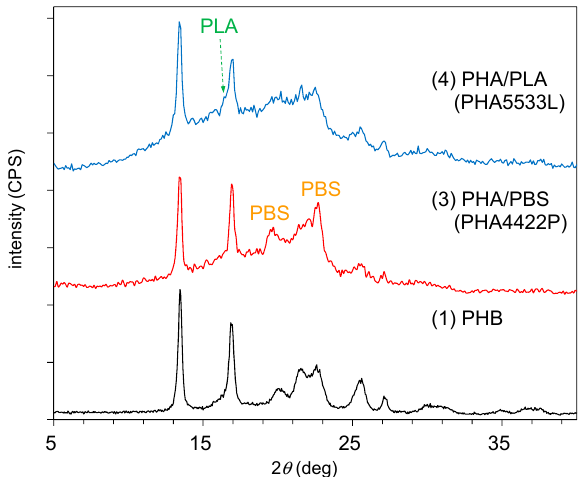
Figure 3. X-ray diffraction (XRD) patterns of plasticized PHA copolymers and original PHB.